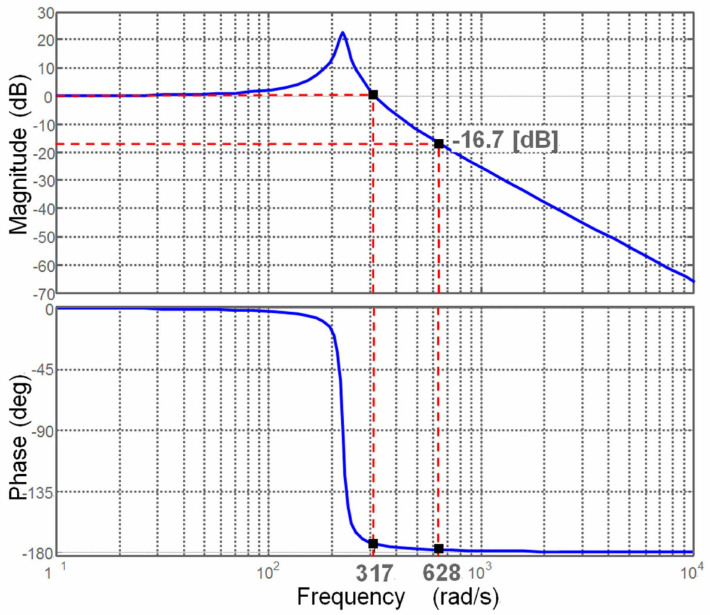
Figure 7. Bode plot for voltage control loop